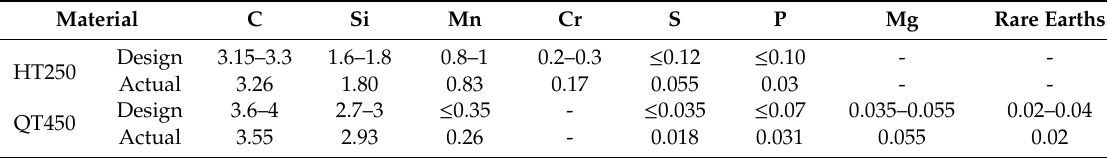
Figure 1. The front bracket casting and its tested parts. Table 1. The composition of HT250 and QT450 in